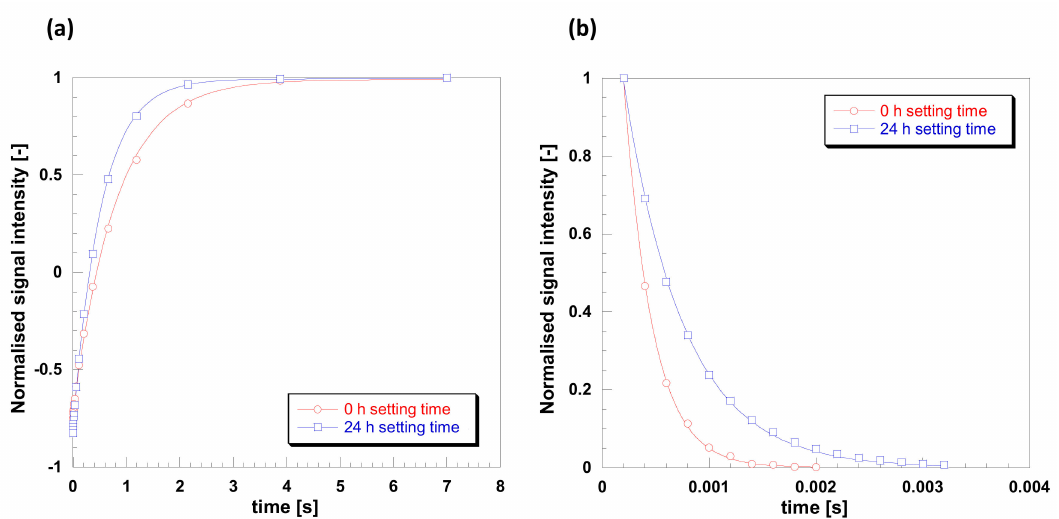
Figure 8. Plots for ( a ) T 1 and ( b ) T 2 relaxation for gelatin with 20% Glyceline for setting times of 0.5 and 24 h setting times at 21 ◦